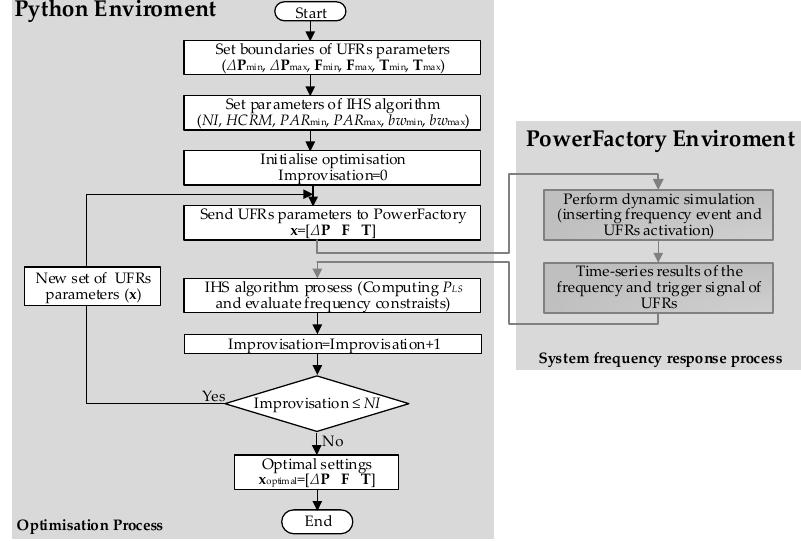
Figure 4. Co-simulation framework for optimal UFLS scheme.